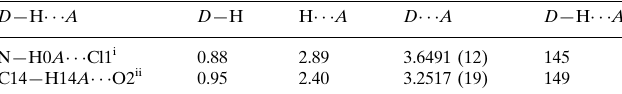
Hydrogen-bond geometry (A˚ , (cid:1)